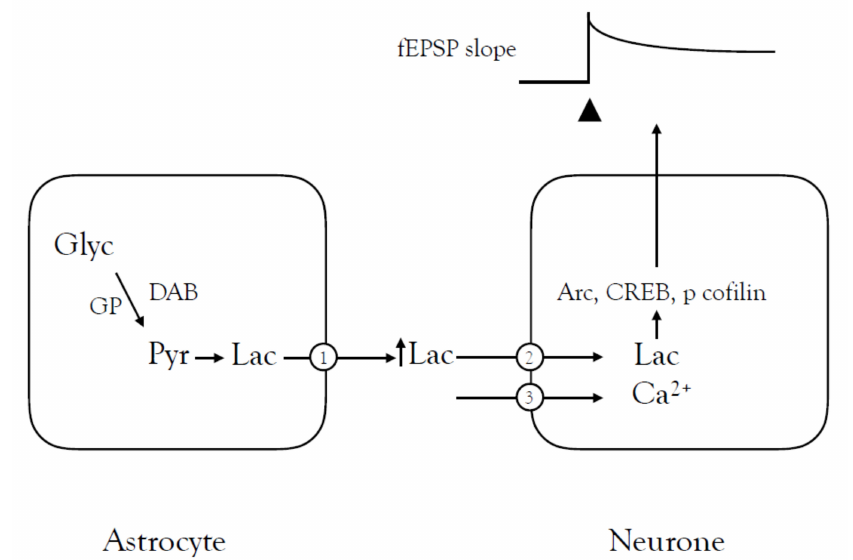
Figure 2. The role of lactate shuttling in learning and memory. A conditioning pulse of high frequency stimulus (100 Hz) initiates the learning process, which is reflected in the sustained increase in the field EPSP slope (upper right image). There is a transient elevation in lactate in the extracellular fluid following the conditioning pulse. The learning can be disrupted by injection of 1,4-dideoxy-1,4-imino-d-arabinitol (DAB, an inhibitor of glycogen phosphorylase) into the hippocampus or applying the N-methyl-D-aspartate (NMDA) receptor (3) antagonist MK-801. This DAB induced inhibition can be circumvented by exogenous application of lactate. Knock down expression of the MCT1 (1) and MCT2 (2) transporters attenuates the learning, but in the case of the MCT1 this can be circumvented via the exogenous application of